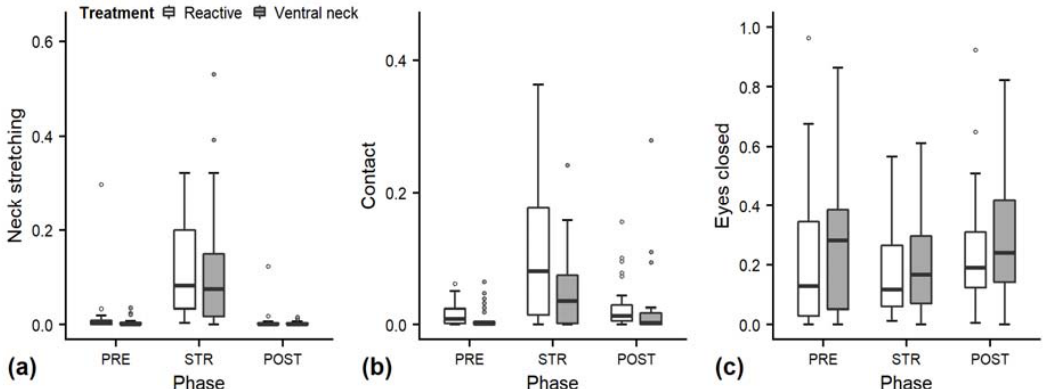
Figure 2. Mean durations (as a proportion of the total time observed) of neck stretching ( a ), contact ( b ) and eyes closed ( c ) of heifers ( n = 28) during the experimental trials. Means were calculated across the three trials per treatment and are depicted according to the treatment used (white = “reactive”, dark grey = “ventral neck”) and phase (PRE = pre-stroking, STR = stroking, POST = post-stroking). Statistics for GLMMs: significant main effect of phase for neck stretching ( a ) and contact ( b ), p < 0.001. Note that the y ‐ axis scale varies to allow for sufficient resolution for rare behaviours. (Figure 2; GLMM: neck stretching: ꭓ ² = 28.838, df = 4, p < 0.001; contact: ꭓ ² = 16.336, df = 4, p = 0.003), as well as for all the tested ear positions (Figure 3; back up: ꭓ ² = 55.738, df = 4, p < 0.001; back centre: ꭓ ² = 27.177, df = 4, p < 0.001; ear low: ꭓ ² = 29.458, df = 4, p < 0.001; centre: ꭓ ² = 15.010, df = 4, p = 0.005; forward up: ꭓ ² = 10.294, df = 4, p = 0.04). The full–null model comparison revealed no significant difference for eyes closed ( ꭓ ² = 4.532, df = 4, p = 0.3).